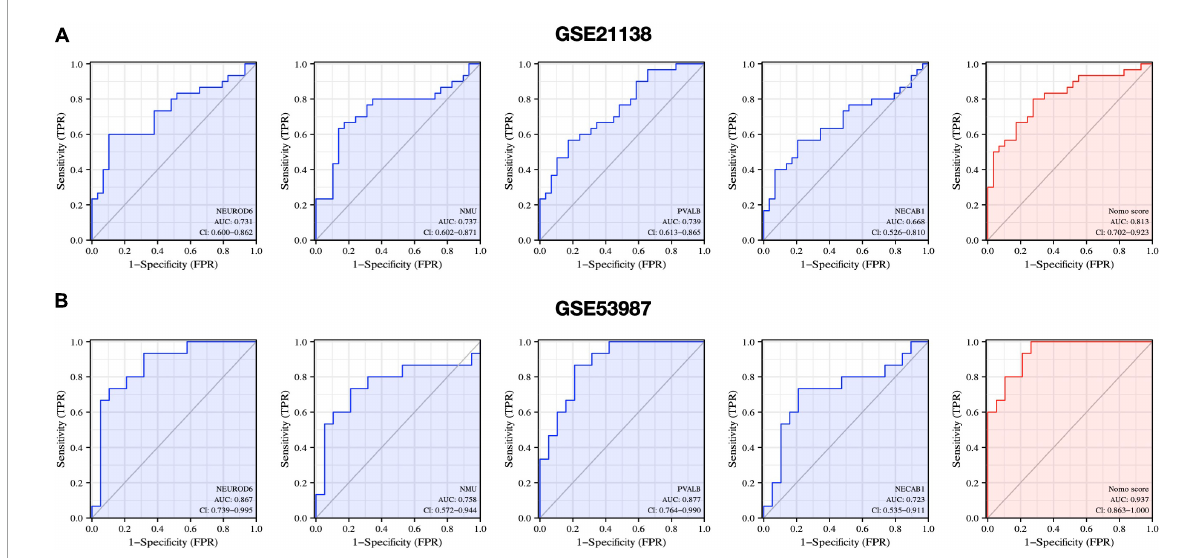
FIGURE11 Diagnostic evaluation of hub genes and nomogram score. ROC curve to evaluate prediction accuracy in (A) GSE21138 and (B) GSE53987.